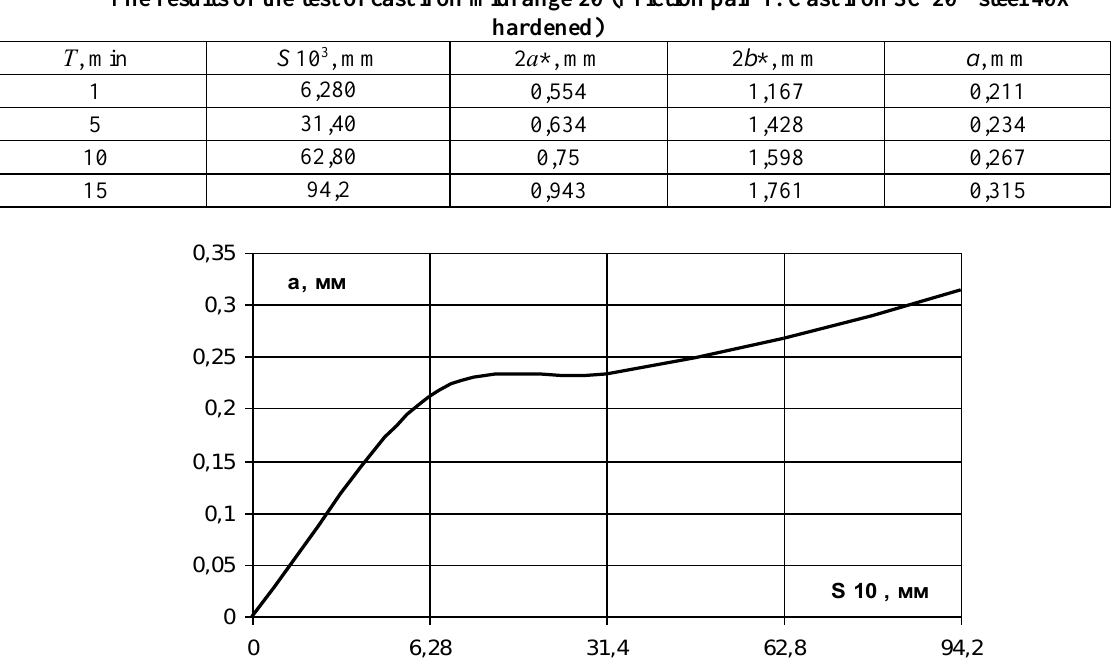
Fig. 2. The plot of the equivalent radius is spotted cast iron SC 20 from the friction path Friction pair 2: Cast iron SC 20 - steel 40X